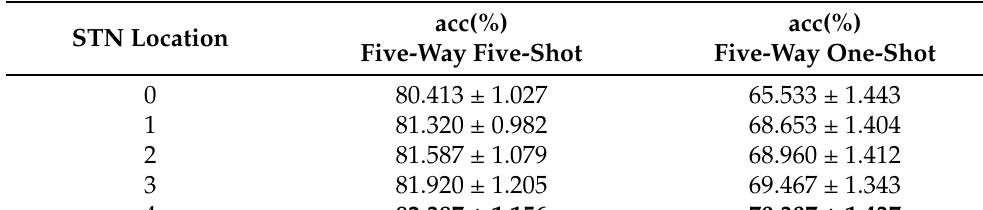
Table 4. Experiments to compare performances with different locations of STM. All the experiments are performed with only STM adopted to the PN baseline. Note that number 0 denotes the location between input and the first convolutional layer, number 1 denotes the location between the first and the second convolutional layer, and so on.